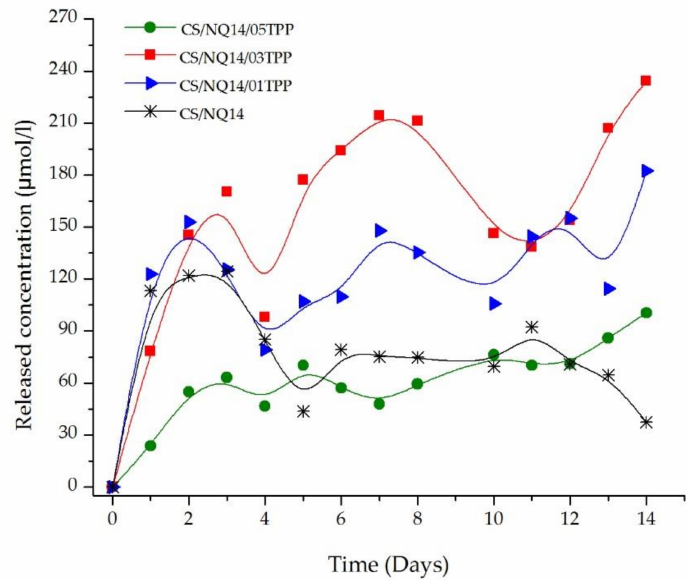
Figure 8. Concentration of NQ14 drug released from non-crosslinked and ionically crosslinked chitosan